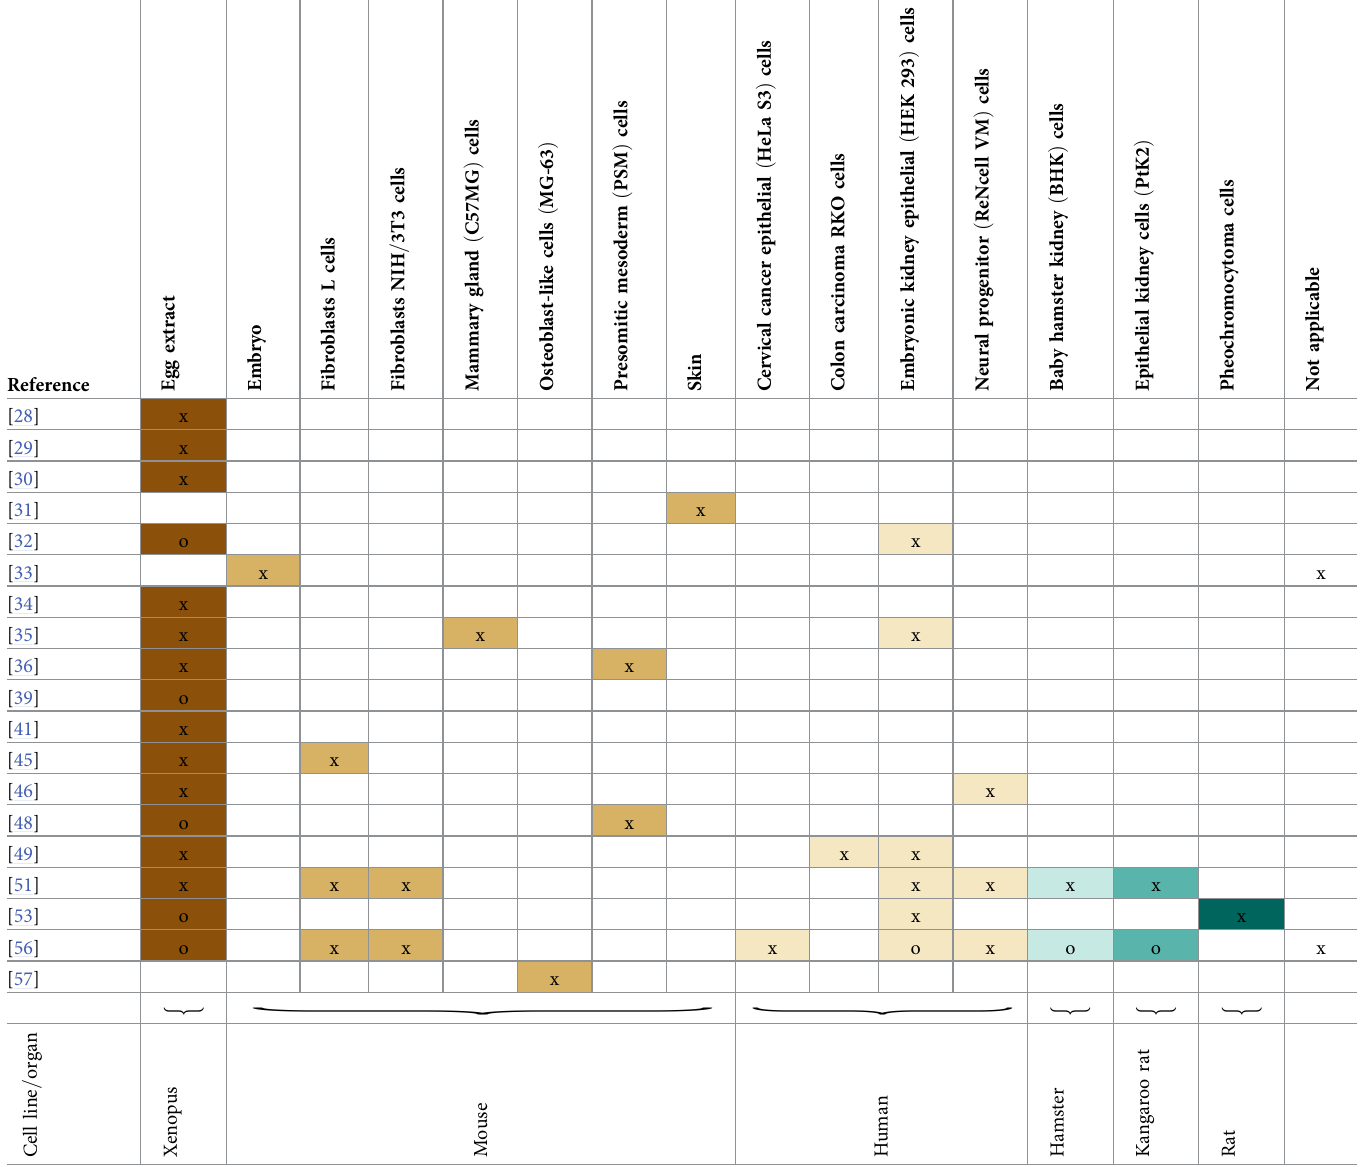
The top row shows the origin of the cells used by the 19 studies. Not applicable means that the parameters values were obtained from theoretical calculations/ considerations from a textbooks or without concrete reference to a wet-lab study. The colors denote the organisms of the cell line/organ used (see bottom row). The “x” denotes directly used , the “o” denotes indirectly used by using (parts of) a referenced simulation model